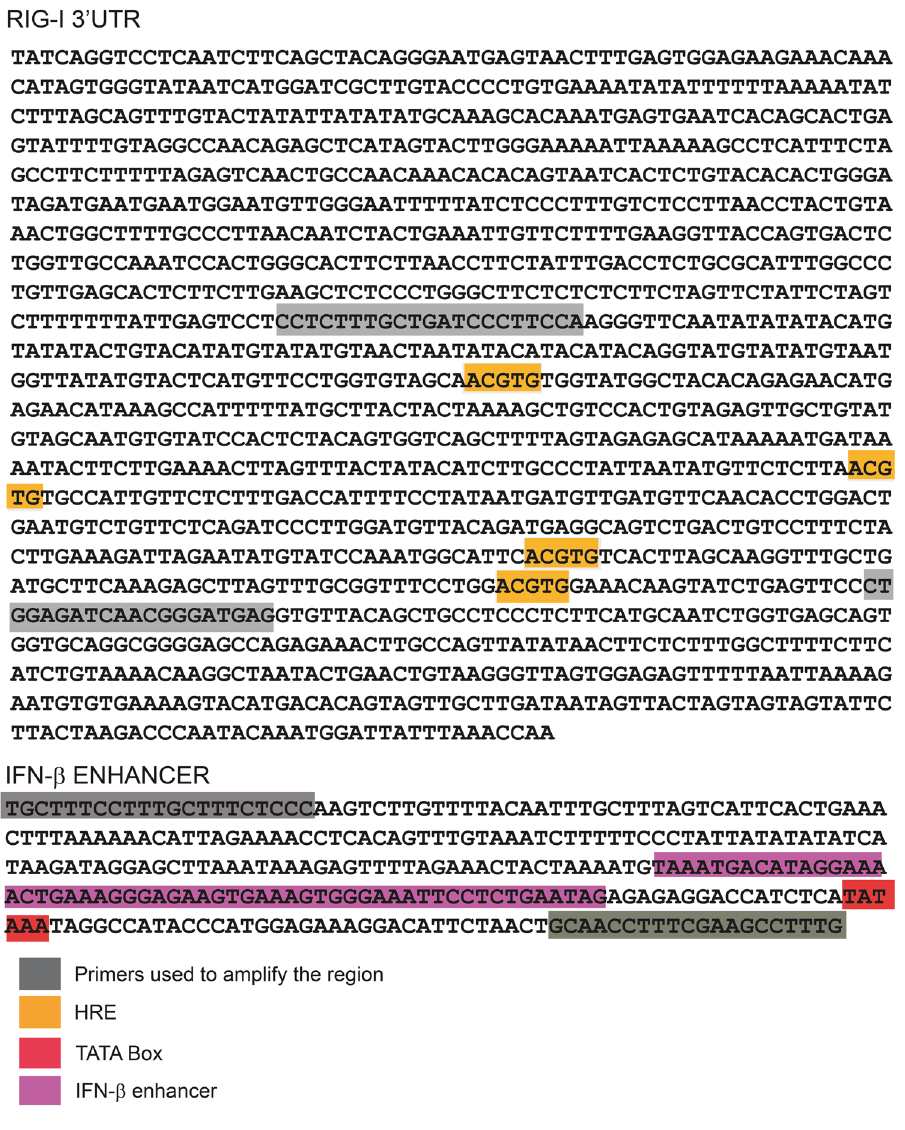
Figure 1. Nucleotides sequences of the cloned fragments of RIG-I 3 ′ UTR and IFN- β enhancer. Sequences of primers used and regulatory elements are highlighted in different